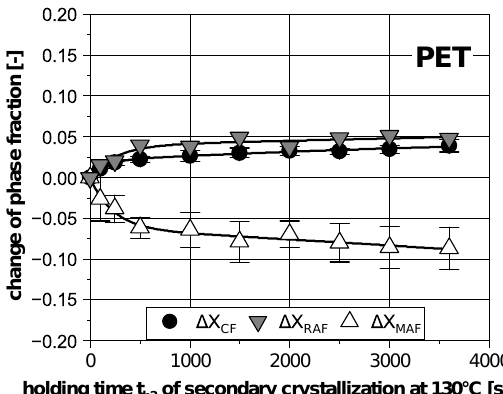
Figure 10. Temporal evolution of the change of phase fractions of PET during secondary crystalliza- tion at 130 °C subsequent to the primary crystallization at 180 °C ( t h 1 = 2000 s). The lines are for visual purposes